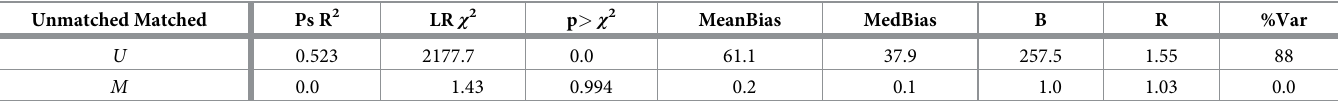
difference in means before matching, but no variables showed a significant difference after matching. Second, the mean bias of each variable fell more than 85% after matching. Addition- ally, the t-tests and p-values show that the control variables are well balanced after matching. The p-value of each independent variable in Table 5 is very large after matching, so we cannot reject the null hypothesis that the variables are identically distributed. In summary, while the distributions of each independent variable differ before matching, there is no significant difference in the distributions after matching between floating population and non-floating population. As shown in Table 6, before matching, the value of Pseudo R 2 was big, and the P-value was small, but after matching, the value of Pseudo R 2 became small and the P-value became big. So for the overall variables, the distribution differs before matching, but there is no significant difference in the distribution after matching. Therefore, it is very necessary to use PSM to esti- mate the migration effect. All test results showed that the control variables have good matching and are therefore well balanced after matching. Estimate the ATTs using various matching methods and some sensible parameter val- ues in the PSM. In the PSM estimation process, there are various common matching meth- ods, such as k-nearest neighbor matching(k = 1,2,3 . . . ), caliper matching(k-nearest neighbor matching of different caliper widths), caliper and radius matching, kernel matching, local Table 6. The results of the balancing